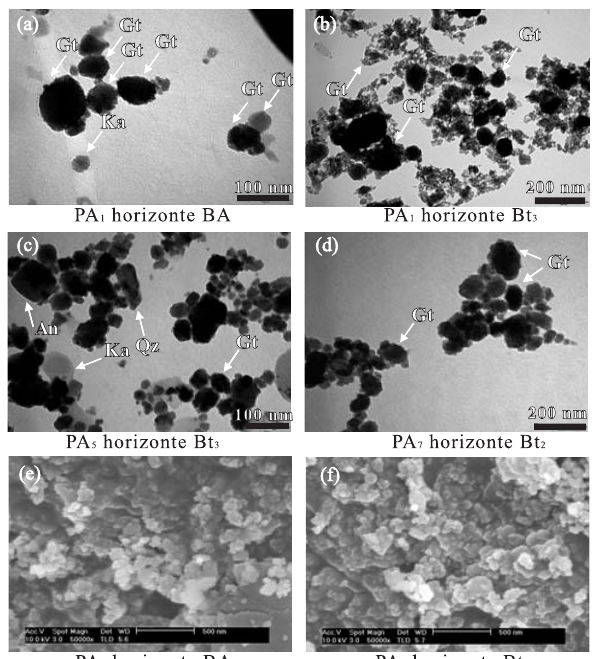
Figura 6. Micrografias obtidas por microscopia eletrô- nica de transmissão (MET) (imagens de a até d) e de varredura (MEV) (imagens e e f) de concen- trados de óxidos de ferro de alguns horizontes de alguns solos amarelos estudados